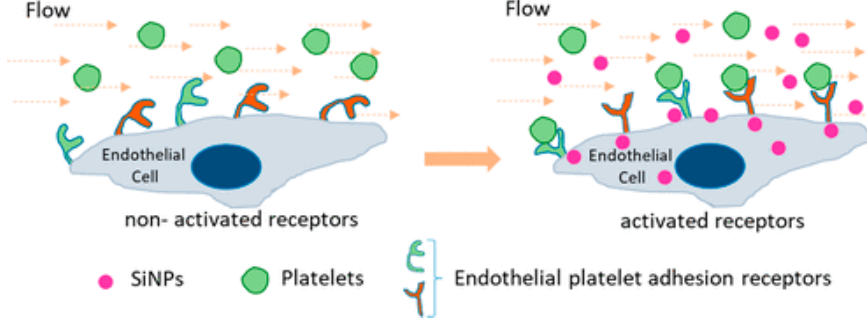
Figure 2. Increased platelet adherence to the surface of endothelial cells in the presence of silica nanoparticles [55].